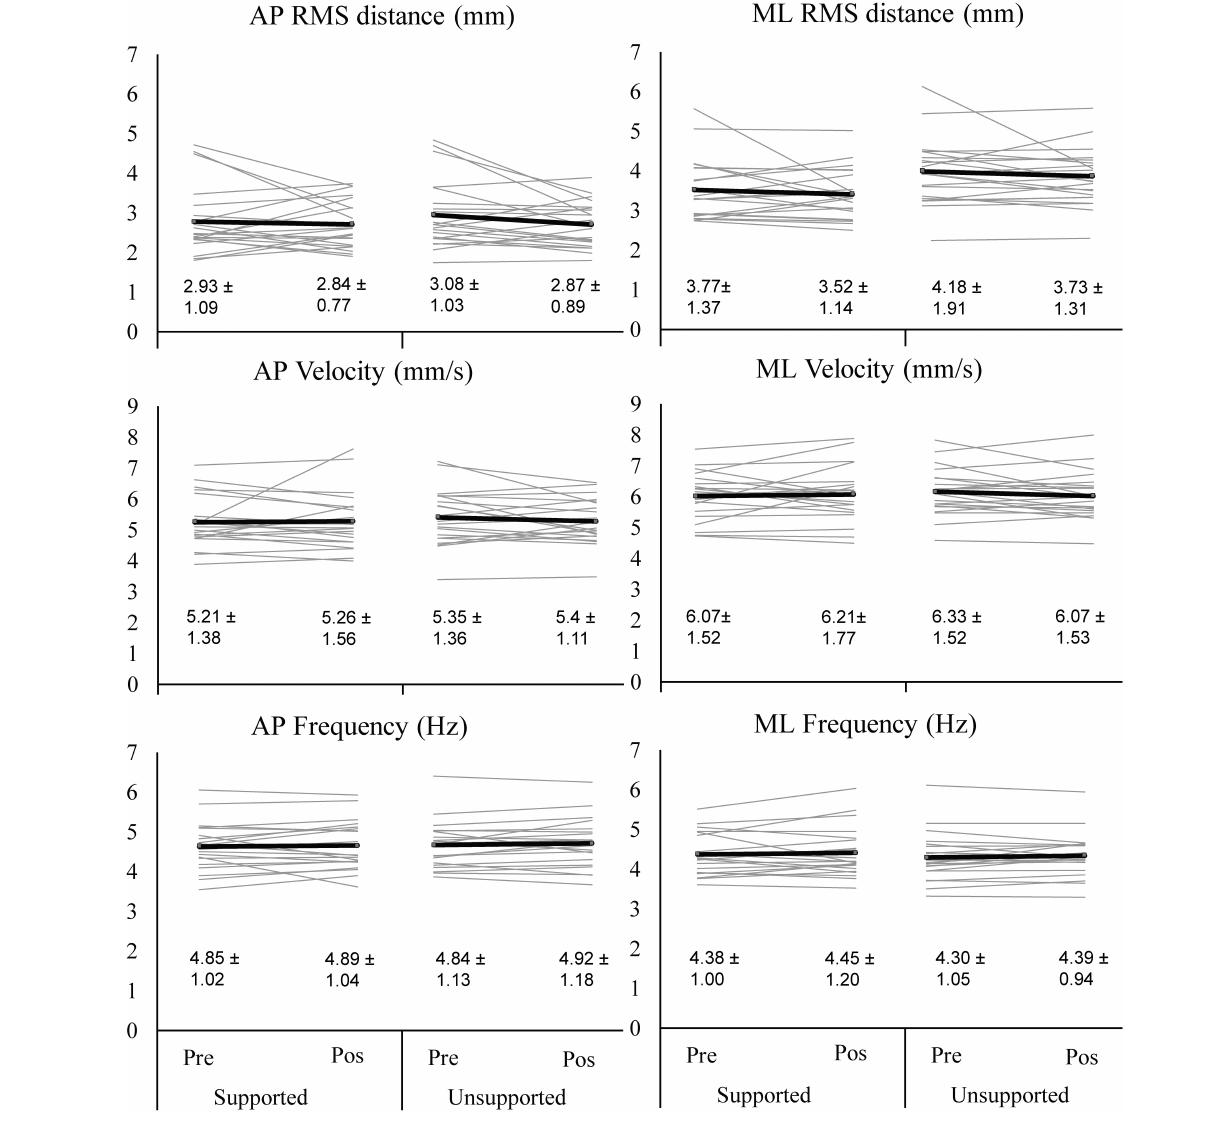
FIGURE 3 | Center of pressure RMS (root mean square) distance, velocity and frequency before (Pre) and after (Pos) the exposure to supported and unsupported flexion. Gray lines indicate individual datapoints, and the black lines represent mean values. Note that combined antero-posterior (AP) and medio-lateral (ML) trajectory showed similar results and none of the effects were significant. The values below the lines are mean ± standard